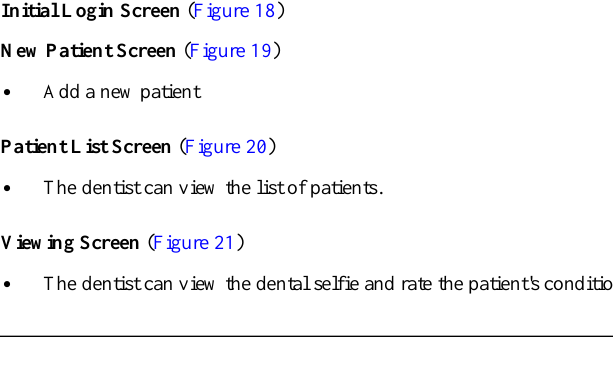
Textbox 2. Prototype screens for dentists in the iGAM app.